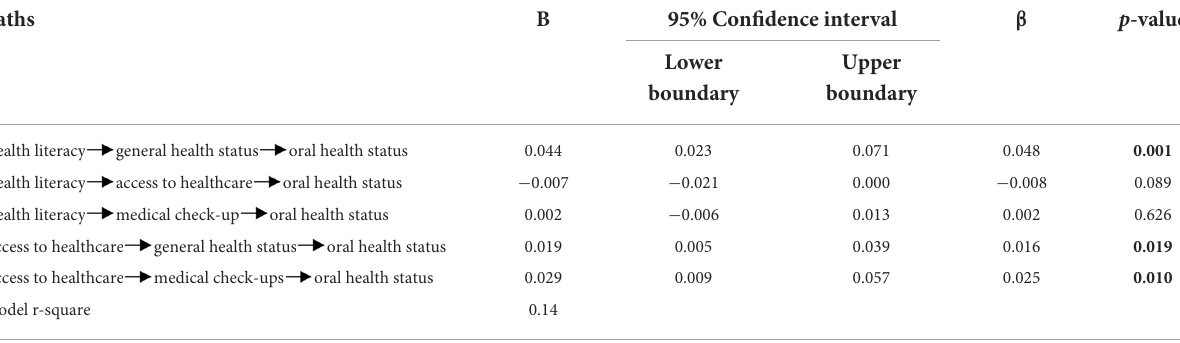
TABLE 5 Indirect effects of health literacy and access to healthcare on oral health status of older persons. Paths